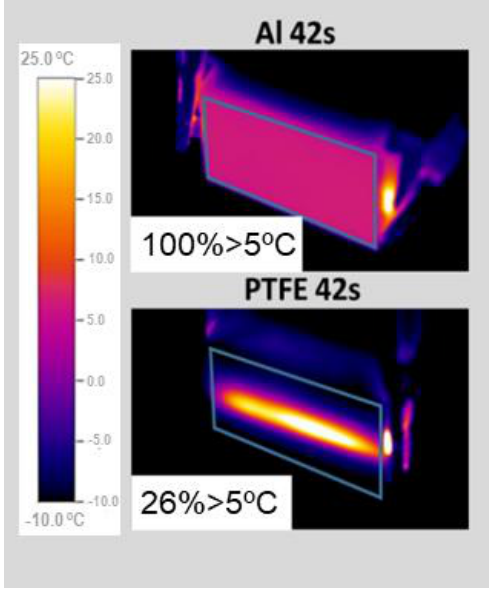
Figure 4. Images showing homogeneous heating AA6061 ( Top ) and heterogeneity of PTFE ( Bot- tom ).